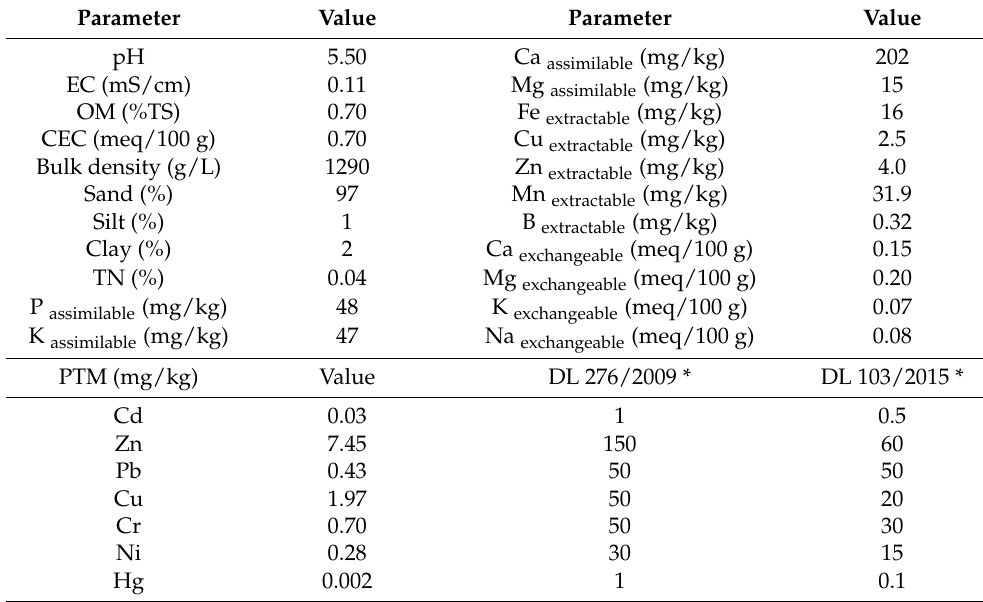
Table 4. Characteristics of the soil used in the experiment.